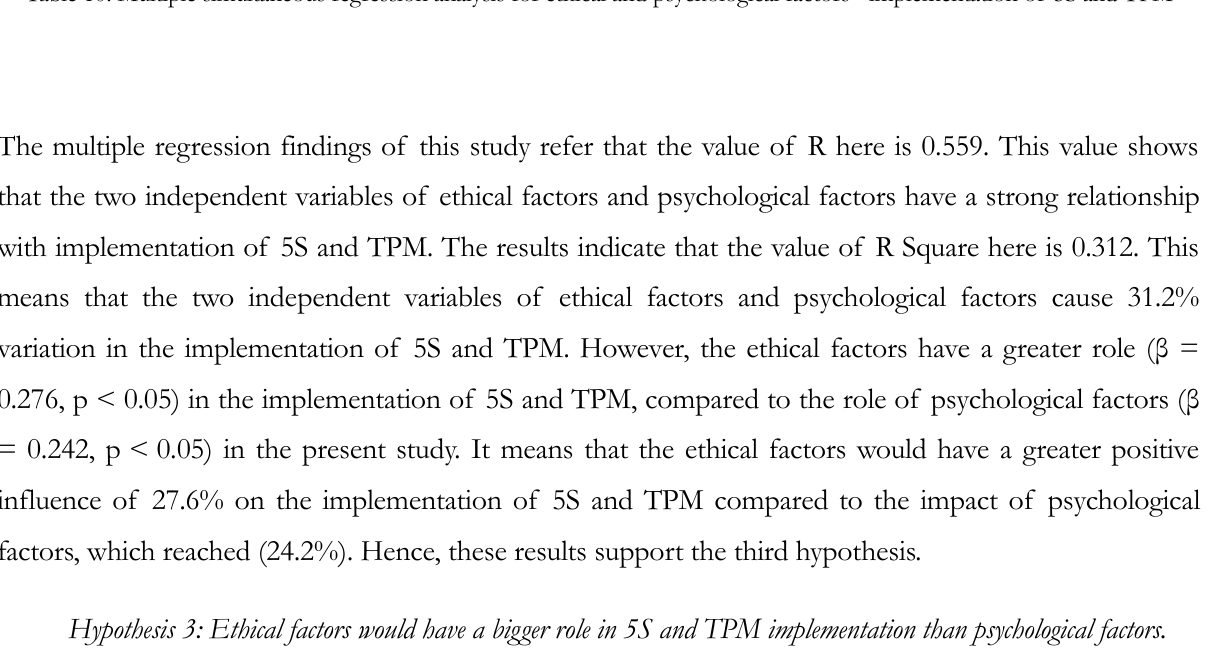
Table 10. Multiple simultaneous regression analysis for ethical and psychological factors - implementation of 5S and